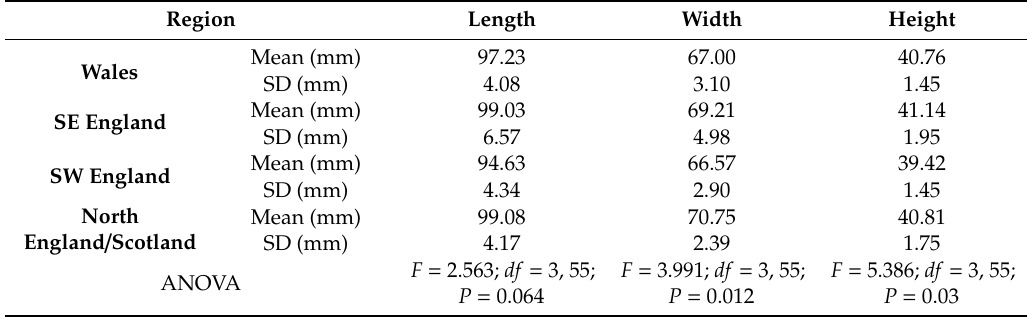
Table 2. Length, width, and height distance measurements of otter crania (physical distance measurements shown here only). Crania from SW England are smaller than those from other areas. (Results from one-way ANOVA are also quoted in this table.).